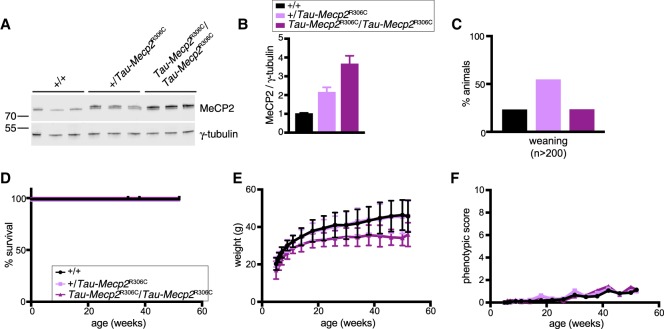
A mutation in the NID renders high MeCP2 overexpression viable. (A) Western blots of three brains of animals heterozygous and heterozygous for Tau-Mecp2[R306C] and of wild-type littermates (males, 7 wk) probed for MeCP2 and γ-tubulin. (B) Quantification of Western blots shown in A (mean and standard deviation). (Black) +/+; (light purple) +/Tau-Mecp2[R306C]; (dark purple) Tau-Mecp2[R306C]/Tau-Mecp2[R306C]. Two-tailed unpaired t-test. n = 3 for each genotype. P = 0.0020 for wild type versus heterozygous; P = 0.0005 for wild type versus homozygous. (C) Genotype distribution from Tau-Mecp2[R306C] heterozygous intercrossings observed at weaning. Legend is as for B. A χ2 test was used to test for normal Mendelian ratios of genotypes. P = 0.7258. (D) Survival of a cohort comprising +/+ (n = 9), +/Tau-Mecp2[R306C] (n = 9), and Tau-Mecp2[R306C]/Tau-Mecp2[R306C] (n = 9). (E) Body weights of the mice shown in D (mean and standard deviation). Two-way repeated measures of ANOVA (excluding one wild-type and one homozygous animal that died) were performed. n = 8 wild type; n = 9 heterozygous; n = 8 homozygous. Genotype effect: F(2,22) = 5.807. P = 0.0094. (F) Phenotypic score of the mice shown in D. Two-way repeated measures of ANOVA (excluding one wild-type and one homozygous animal that died) were performed. n = 8 wild type; n = 9 heterozygous; n = 8 heterozygous. Genotype effect: F(2,22) = 0.309. P = 0.7373.